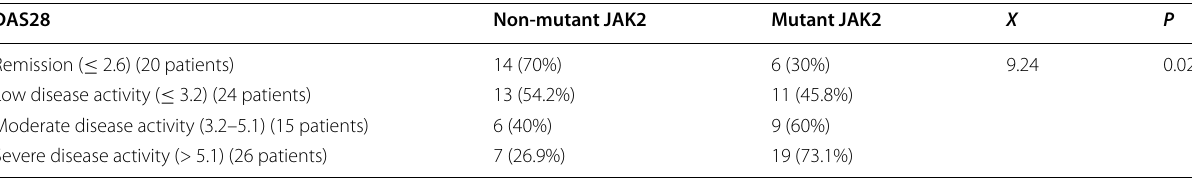
Table 2 DAS28 scores of mutant and non‑mutant JAK2 RA patients